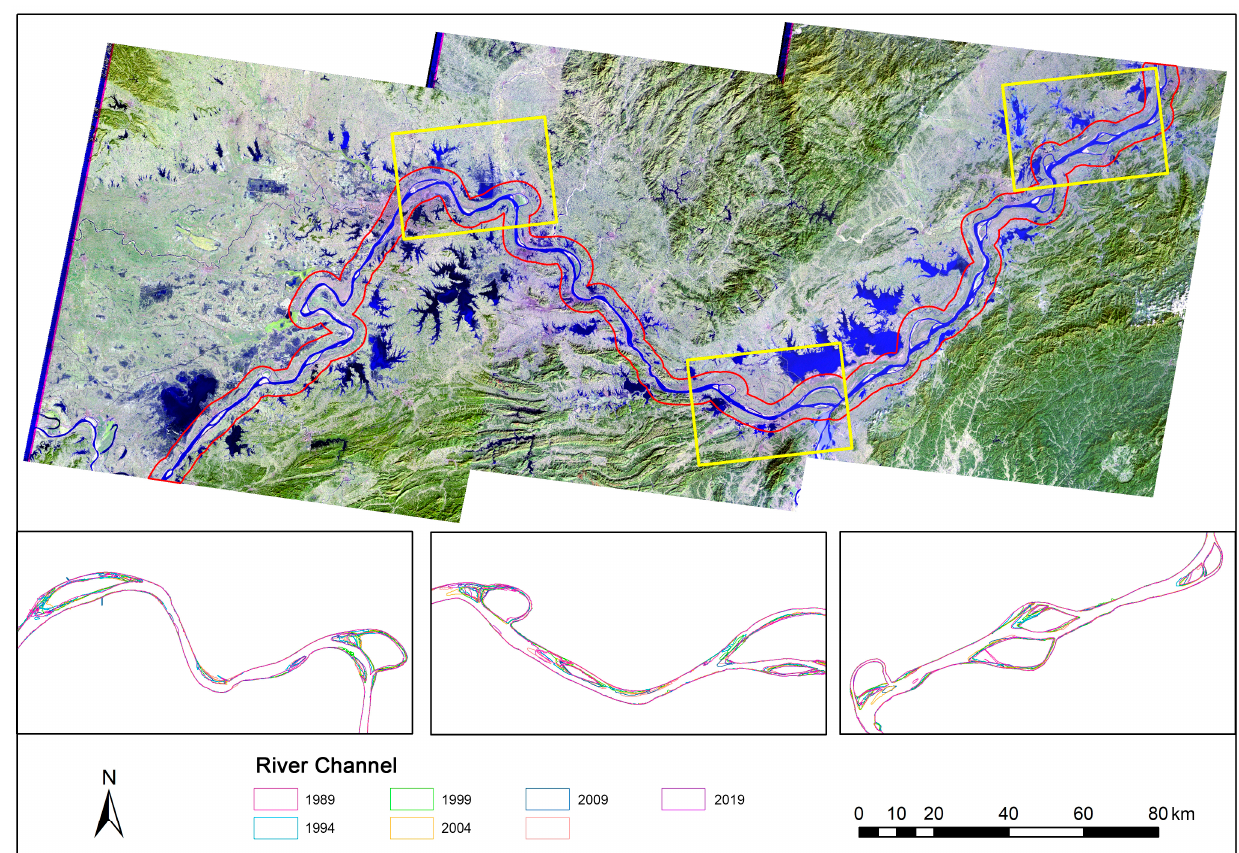
Figure 2. Changes in shoreline movement from the Chenglingji to Datong River section at different periods.